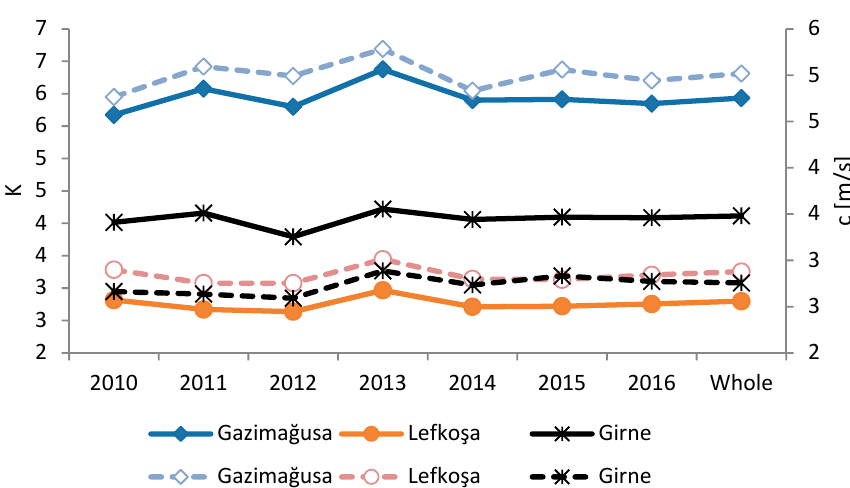
Figure 6. Yearly variation of shape and scale parameters for the areas at 10 m height (k: solid line; c: dashed line).